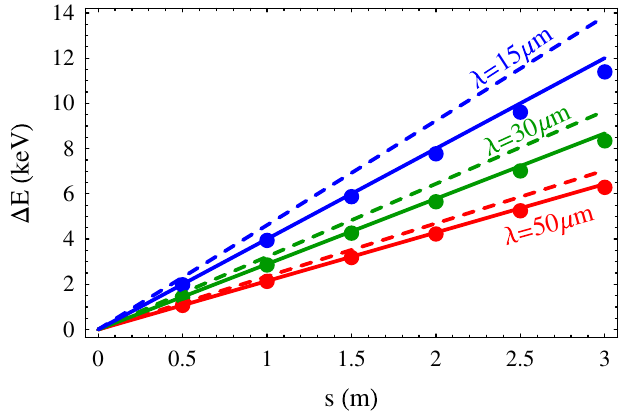
FIG. 2. (Color) Amplitude of energy modulations as a function of distance induced by space charge starting from initial 5% current sinusoidal modulations with wavelengths (cid:9) ¼ 15 (cid:6) m , 30 (cid:6) m , and 50 (cid:6) m for a beam drifting in free space with initial uniform transverse density, circular cross section, and vanishing emittance. The results from IMPACT simulations (dots) are com- pared to the longitudinal space-charge impedance models of Eq. (19), dashed lines, and Eq. (21), solid